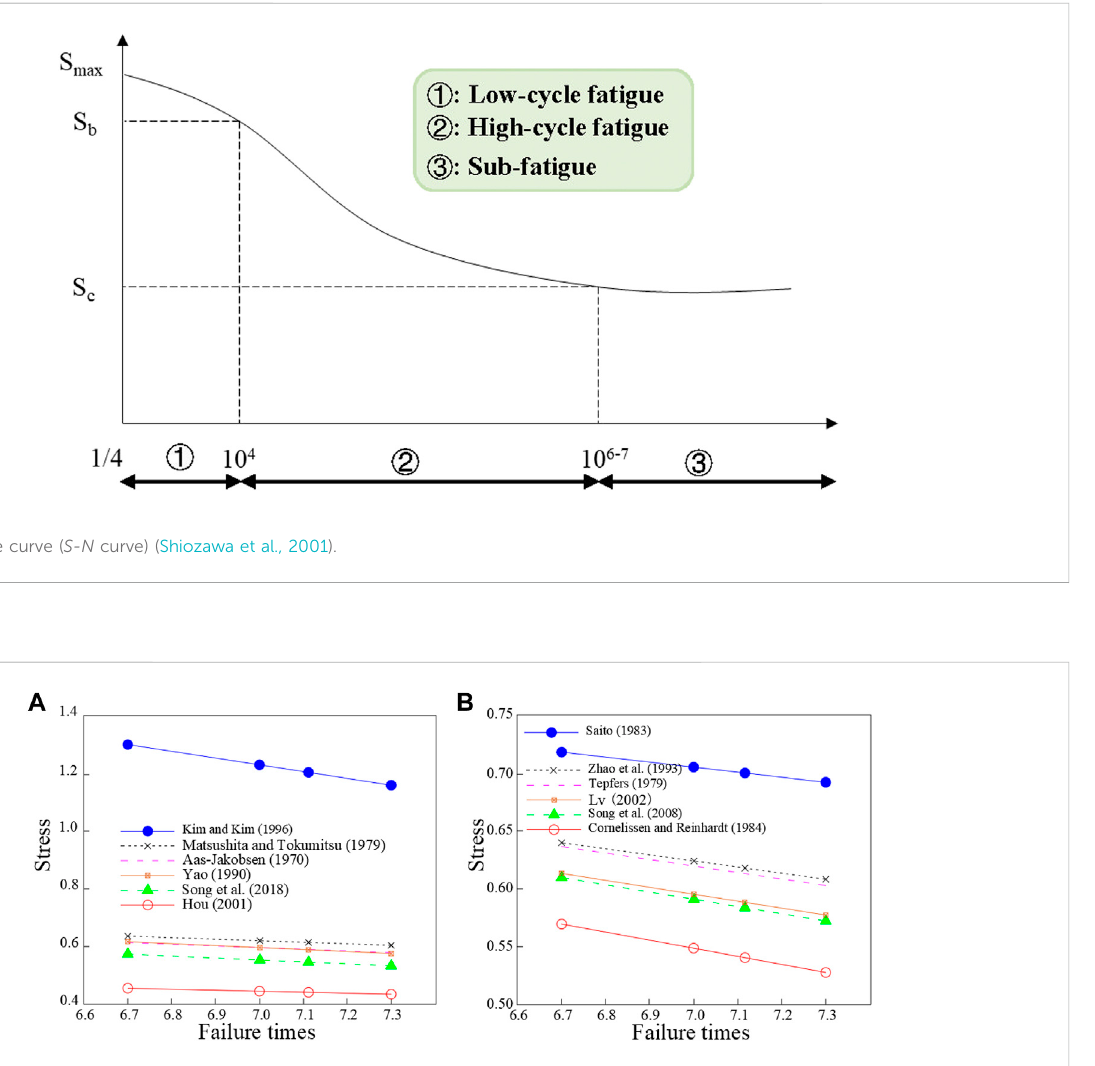
FIGURE 2 Comparative analysis of fatigue equation results for concrete under (A) compression conditions (Aas-Jakobsen, 1970; Matsushita and Tokumitsu, 1979; Yao, 1990; Kim and Kim, 1996; Hou, 2001; Song et al., 2008); and (B) tension conditions (Song et al., 2008; Tepfers, 1979; Saito, 1983; (Zhao et al., 1993) (Cornelissen and Reinhardt, 1984) (Lü,